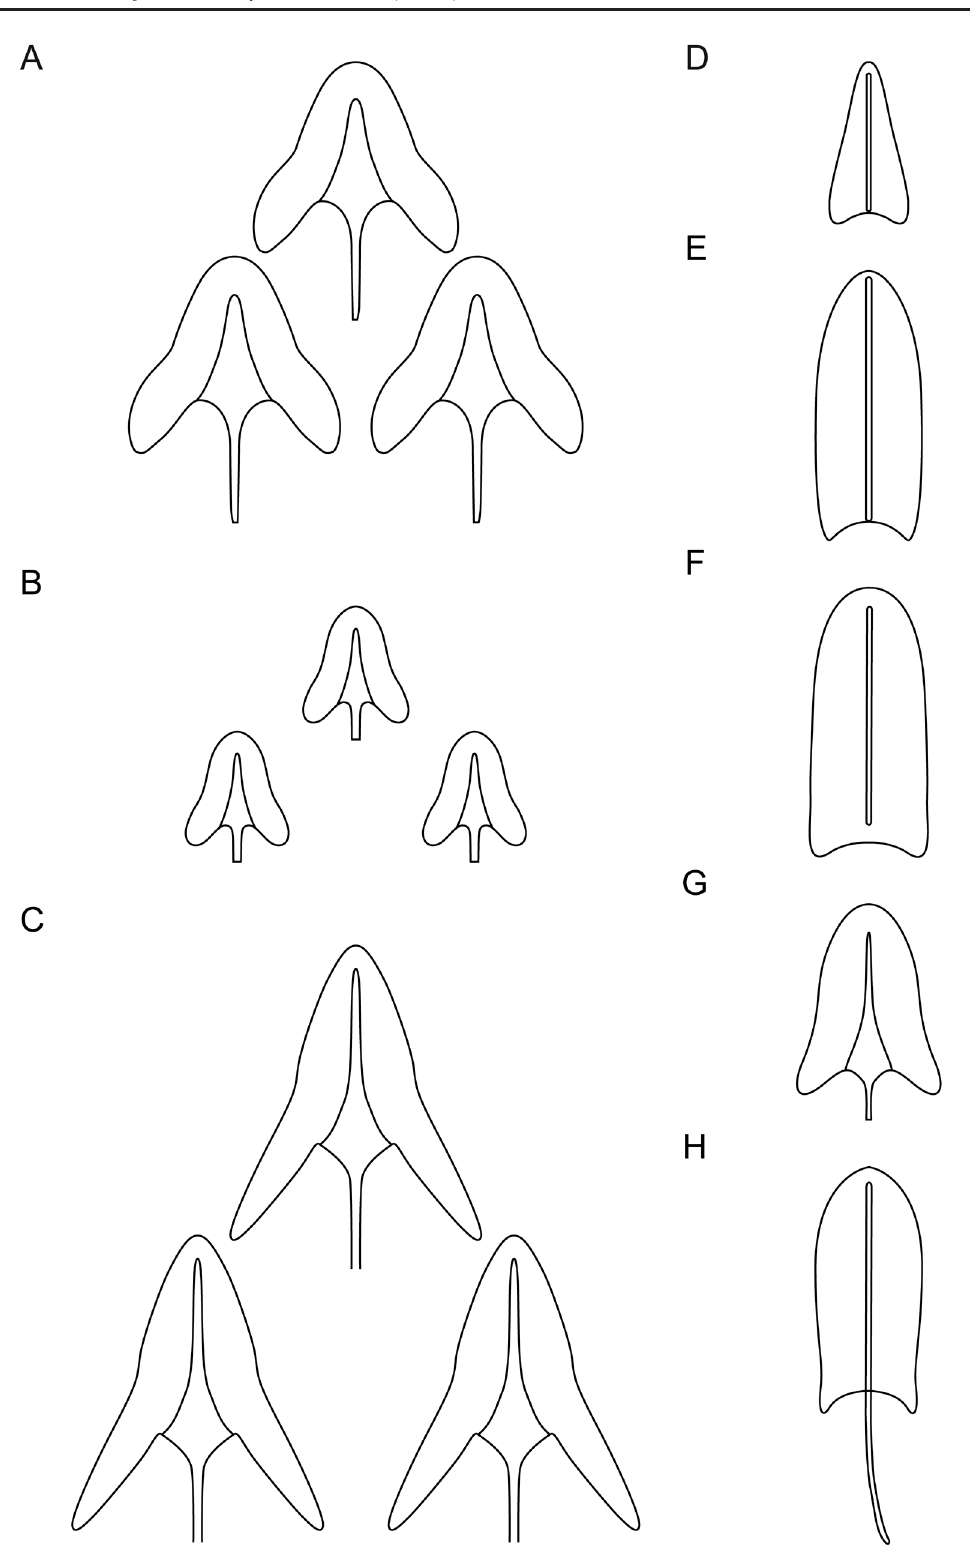
Fig. 5. Chaetonotus (Chaetonotus) antrumus Kolicka sp. nov., schematic drawings of the scales. A . Head region scales. B . Neck region scales. C . Trunk region scales. D . Ventral interciliary field scales. E . Posteriormost ventral field scales. F , H . Furcal appendages dorsolateral one–lobed scales. G . Furcal appendages dorsal three-lobed